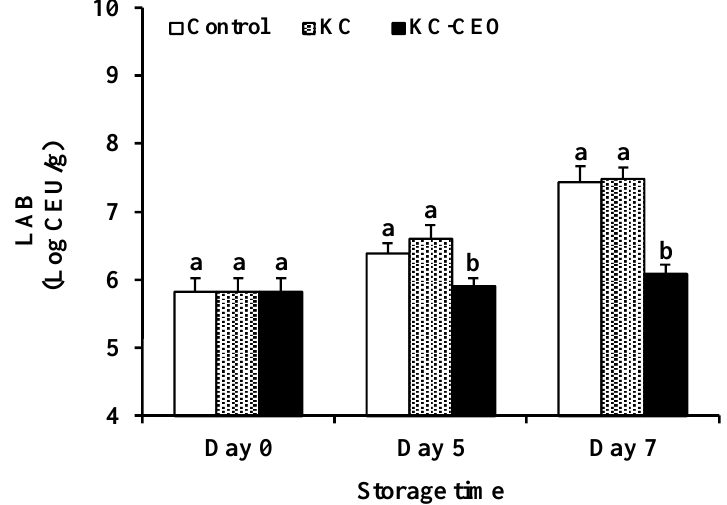
Figure 2. Impact of KC-based coatings on the number of LAB in pork meat during refrigerated storage (4 ◦ C). KC, kappa-carrageenan; CEO, cinnamon essential oil; LAB, lactic acid bacteria. Different letters for data points on each day represent significant differences ( p < 0.05).